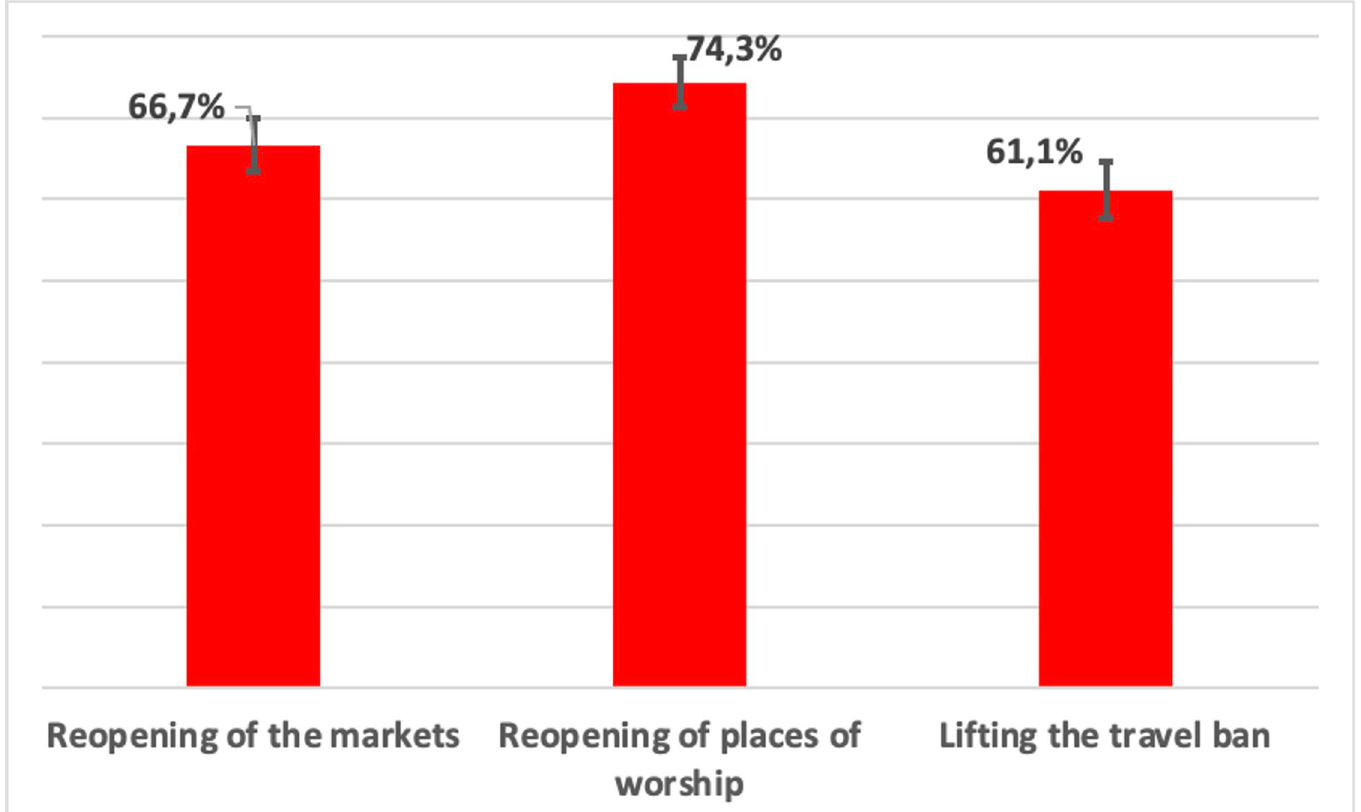
Fig 3. Agreement on the suspension of three